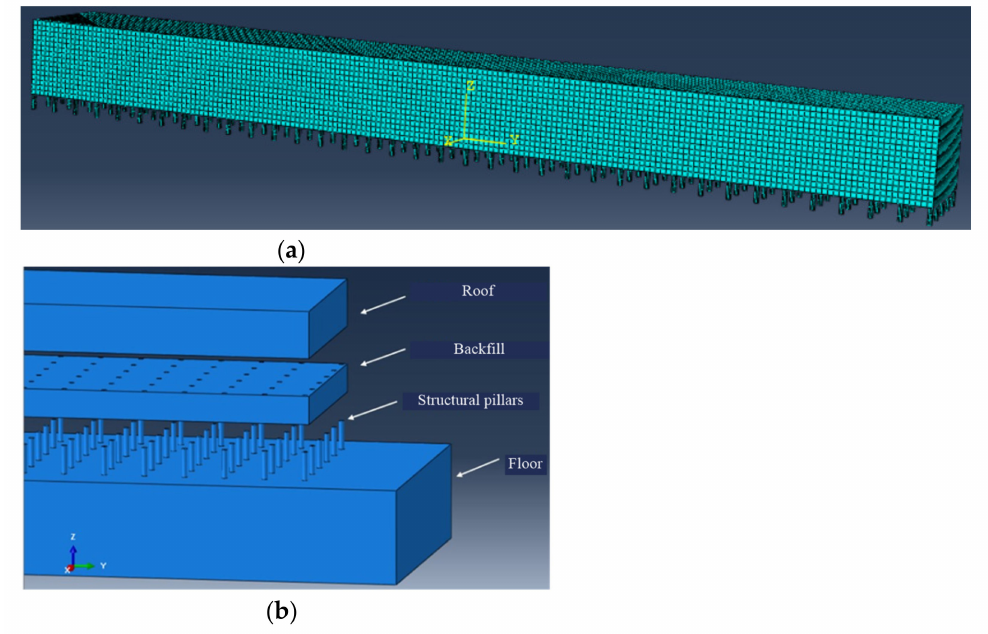
Figure 9. Finite element model of structural pillars backfill. ( a ) Global model diagram; ( b ) Local component diagram.